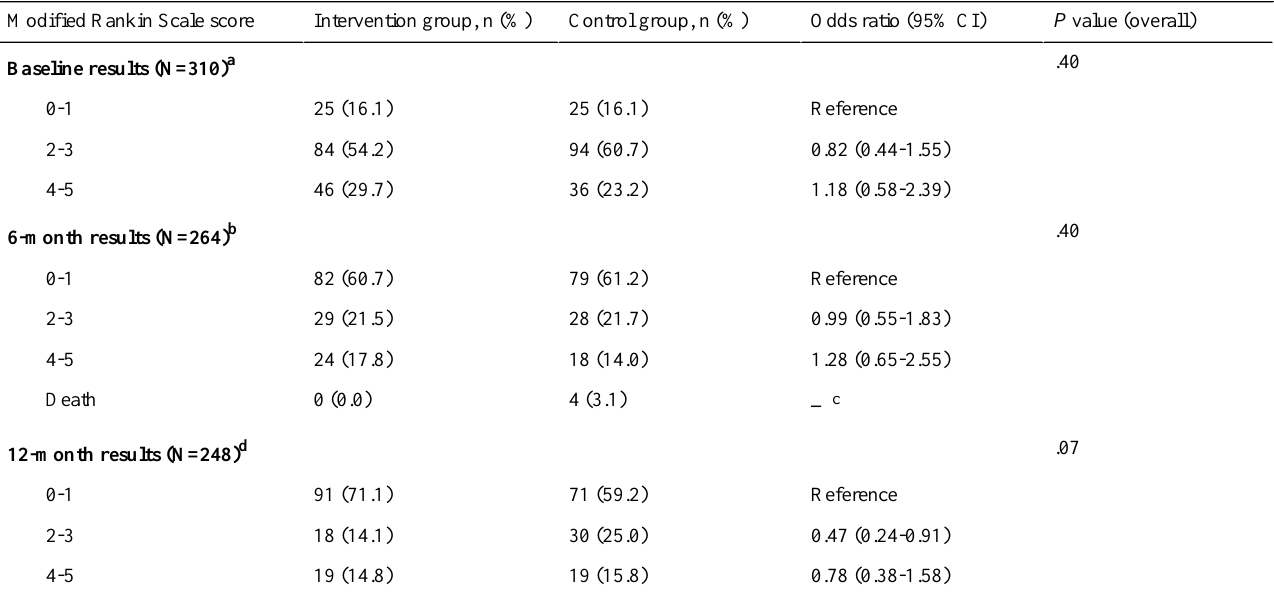
Table 7. Modified Rankin Scale.